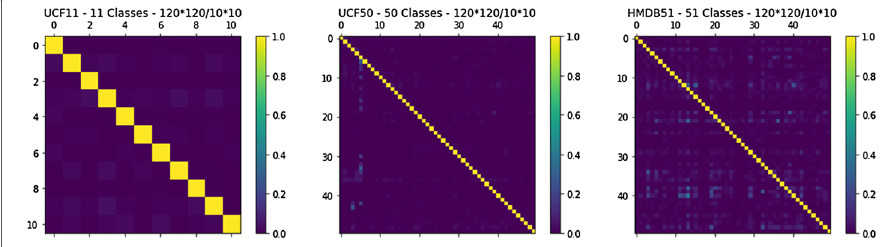
Fig. 14 Comparison of video classes’ accuracy of S ∗∗